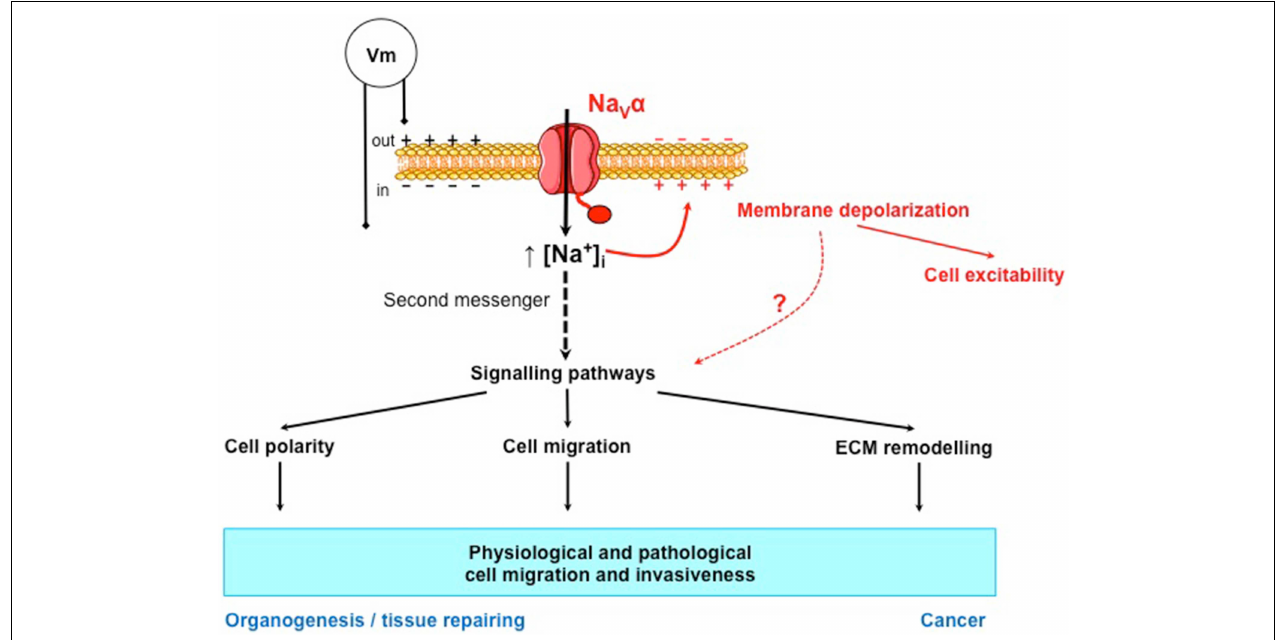
considered as a second messenger since it regulates, directly or indirectly, many signaling pathways involved in cell polarity, cell migration, and extracellular matrix (ECM) remodeling. These properties are involved in physiological cell migration and invasiveness, such as in organogenesis and tissue repairing and also in the pathological migration and invasiveness of cancer